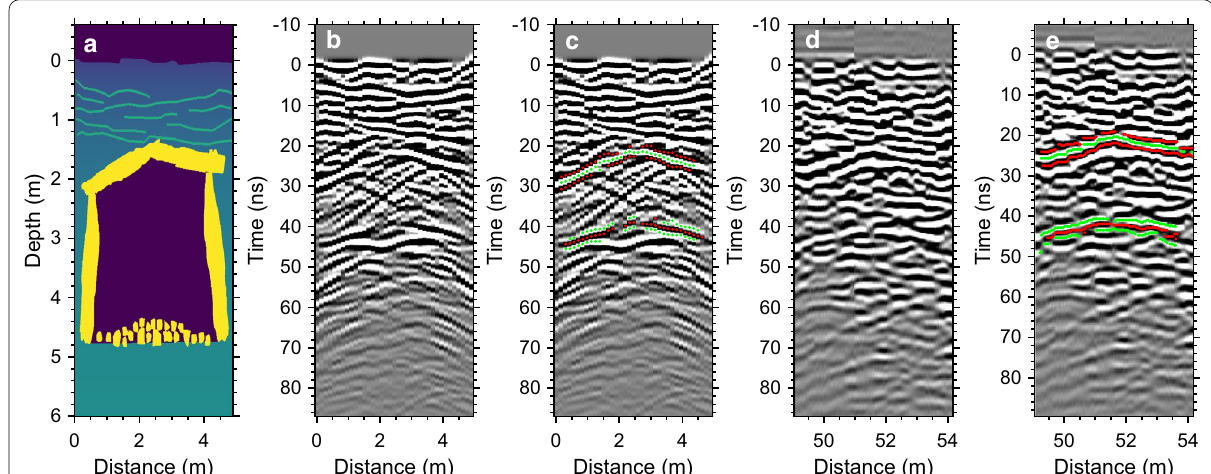
Fig. 6 Comparison between the observed radargram and that derived from a more realistic regolith model that contains a subsurface cavity. a A complex yet still simplified subsurface cavity model in lunar regolith. Blocks supporting the subsurface cavity have shapes adapted from ejected blocks around fresh impact craters (Krishna and Kumar 2016). The blocks have an assigned relative permittivity of 7.5 and thicknesses of ~ 0.35 m. The width of the cavity is assumed to be ~ 4 m here, and its height is set to ~ 3 m. Small irregularly shaped rocks are added at the bottom of the cavity. Multilayered structures are implanted within the shallow regolith, as shown in Fig. 4. The background relative permittivity is cited from the empirical equation of the Apollo core samples (Carrier et al. 1991). b Simulated radargram based on the model shown in panel a . c Annotated phase reversals in the simulated radargram, and the positive and negative amplitudes of the echo patterns are shown in green and red, respectively. d and e are the observed radargram and annotated phase reversals,